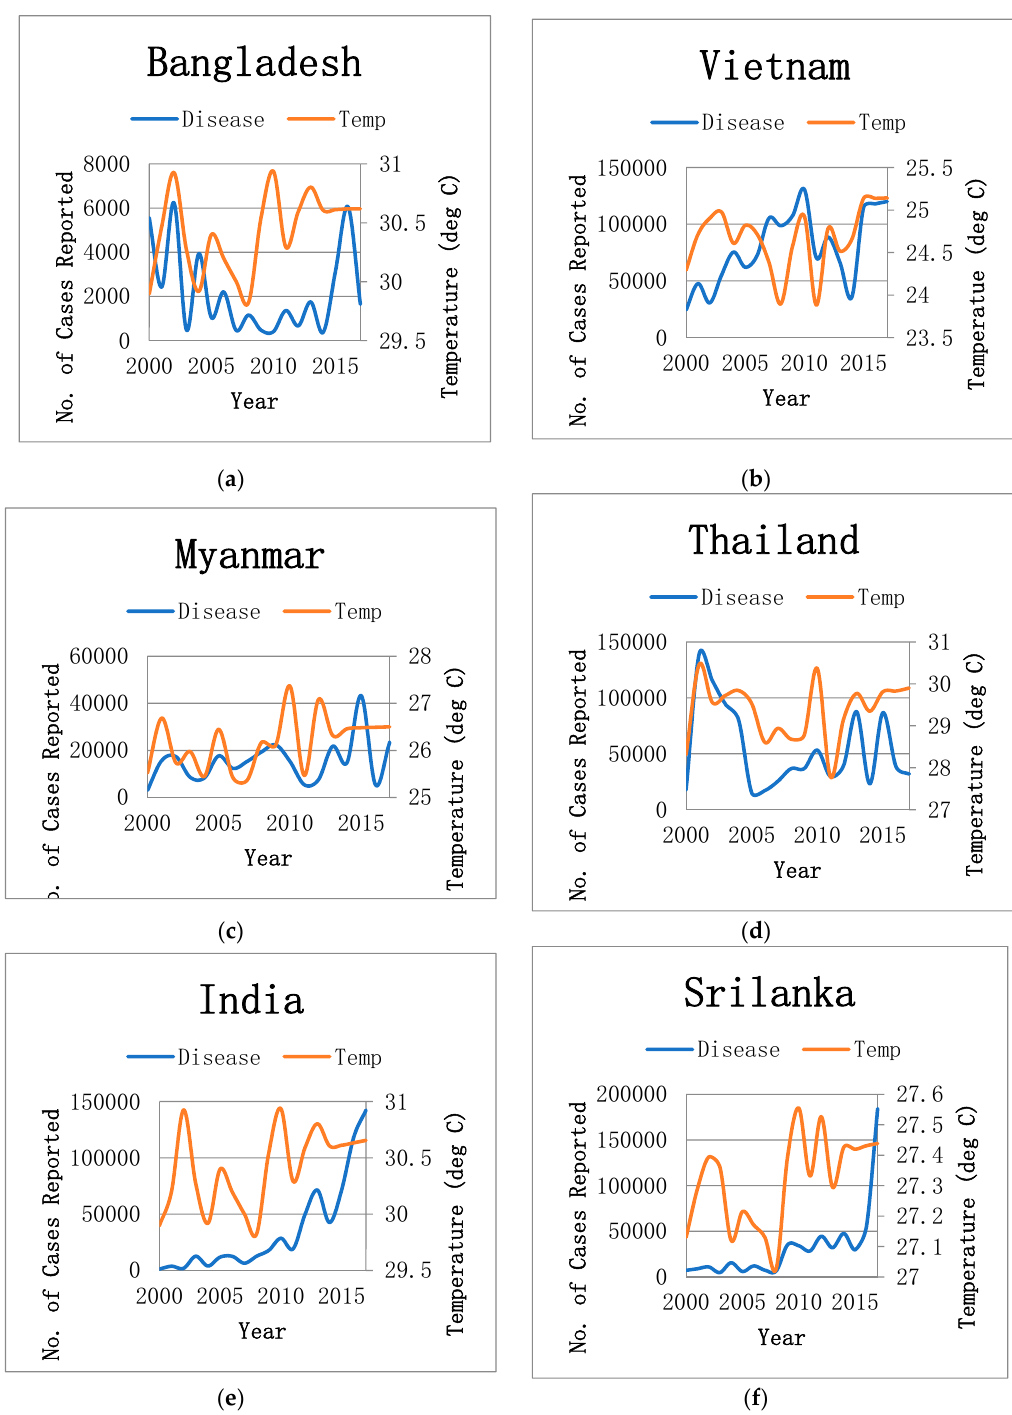
Figure 2. Temperature and number of dengue reported cases in individual countries. ( a ) Bangladesh, ( b ) Vietnam, ( c ) Myanmar ( d ) Thailand, ( e ) India, ( f ) Srilanka.